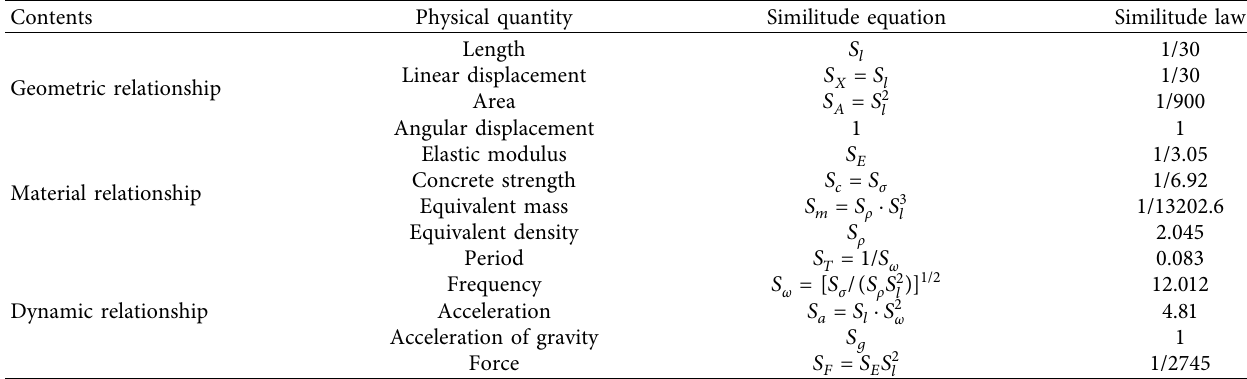
Table 2: Similitude law.